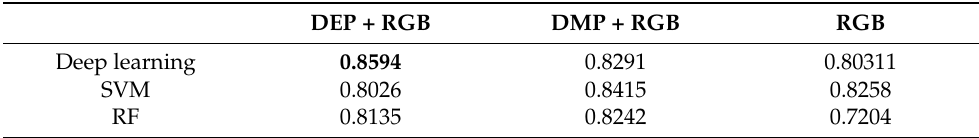
Table 7. Kappa coefficient for World-View 2 dataset.